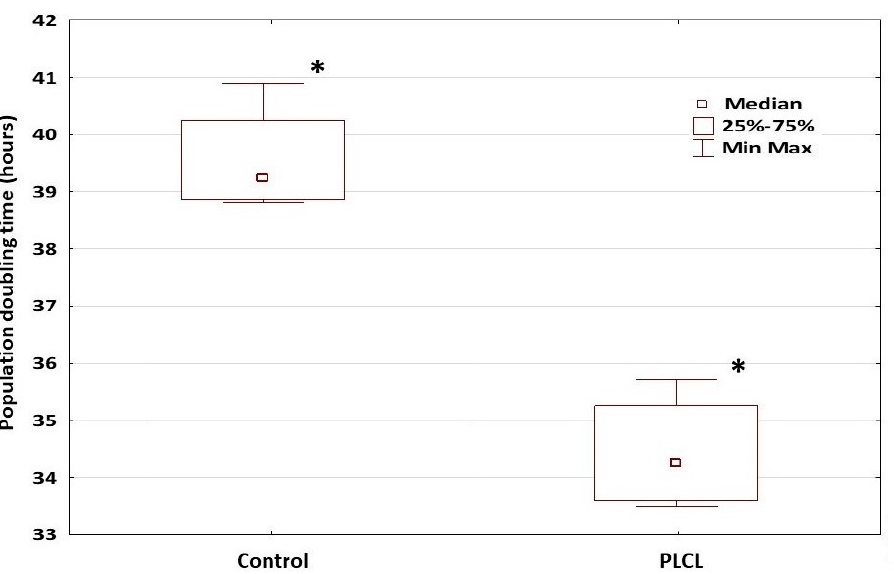
Figure 7. Population doubling time (PDT) efficiency. PDT of hDPSCs cultured on PLCL showed significantly lower PDT than hDPSCs cultured as a monolayer (* p < 0.01). Columns illustrate median PDT ± SD. Three independent PDT assays were performed for each case ( n = 4).